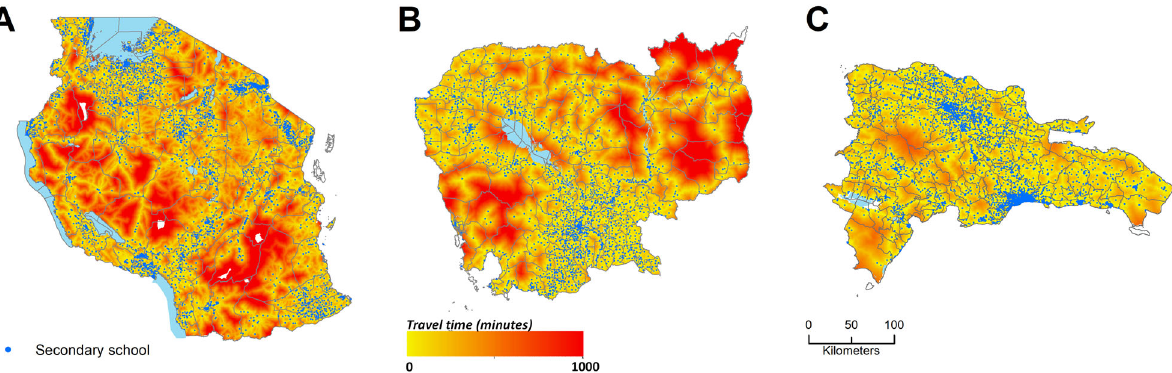
Fig. 2 Secondary school accessibility maps. Estimated travel time (minutes) to the nearest secondary school in the three countries ( A ) Tanzania, ( B ) Cambodia, and ( C ) the Dominican Republic. The blue dots represent the spatial distribution of school secondary schools in the three countries, respectively.